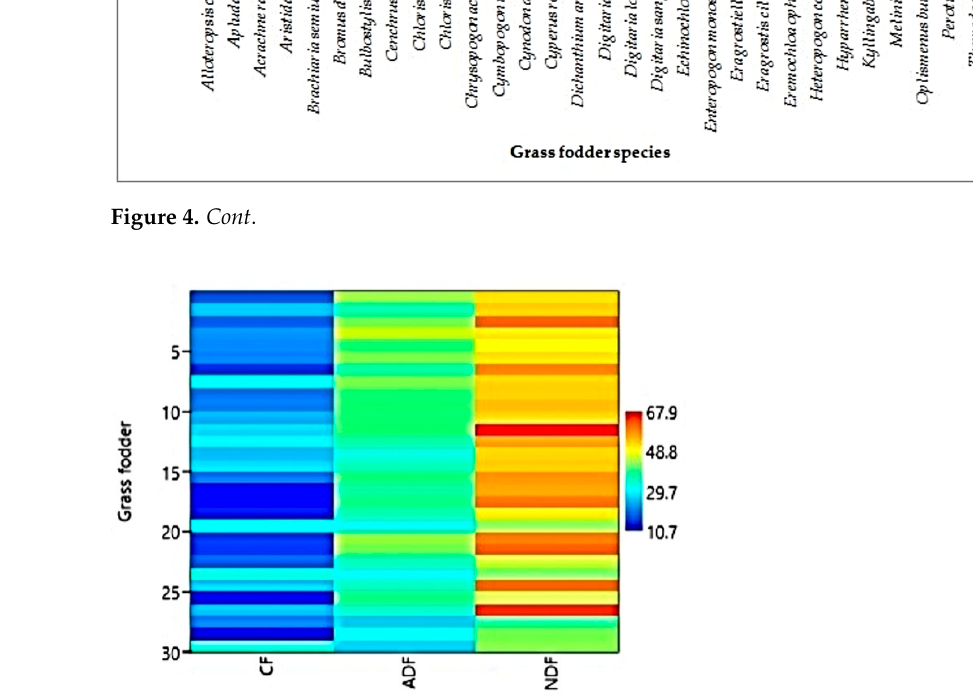
Figure 4. Crude fibre (CF), acid detergent fibre (ADF) and neutral detergent fibre (NDF) per cent in native grass fodder species.